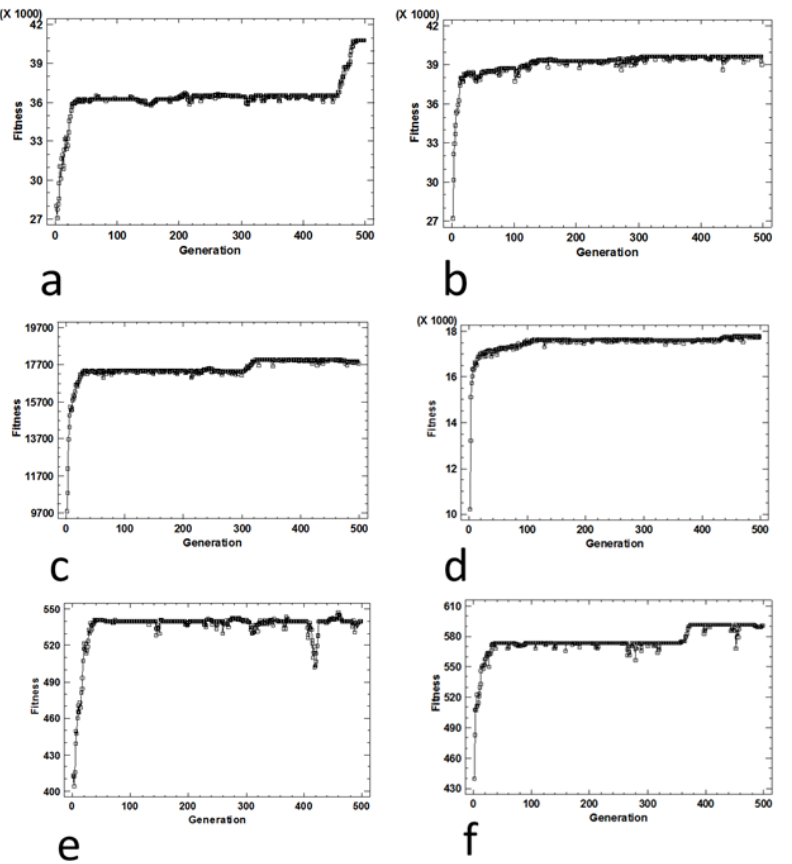
Figure 10. Performance graph (average fitness per generation) for the 0 / 1 knapsack problem obtained under ( a ) SGA with antibiotic screening procedure, ( b ) SMGA with antibiotic screening procedure, ( c ) SGA with the Lac operon screening procedure, ( d ) SMGA with the Lac operon screening procedure, ( e ) SGA with chemotaxis screening procedure and ( f ) SMGA with chemotaxis screening procedure